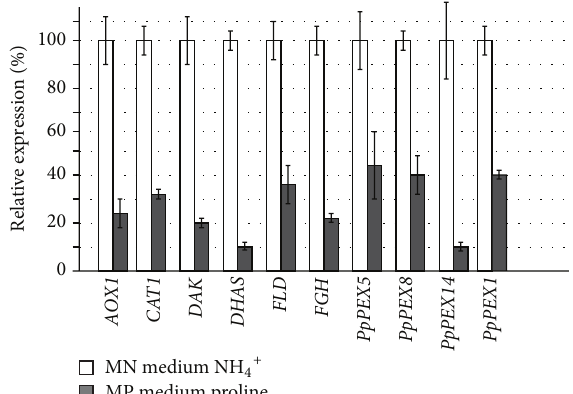
Figure 1: Quantitative analysis of the relative expression levels of PpDAK , PpDHAS , PpFLD , and PpFGH and PpPEX5 , PpPEX14 , PpPEX8 , and PpPEX1 genes depending on the nitrogen source in the medium. MN medium contained ammonium sulphate and 1% methanol. MP medium contained proline and 1%